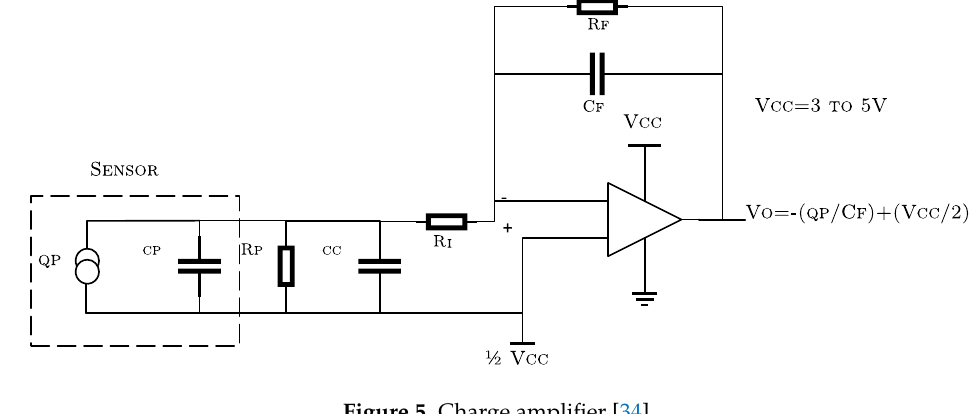
Figure 5. Charge amplifier [34].